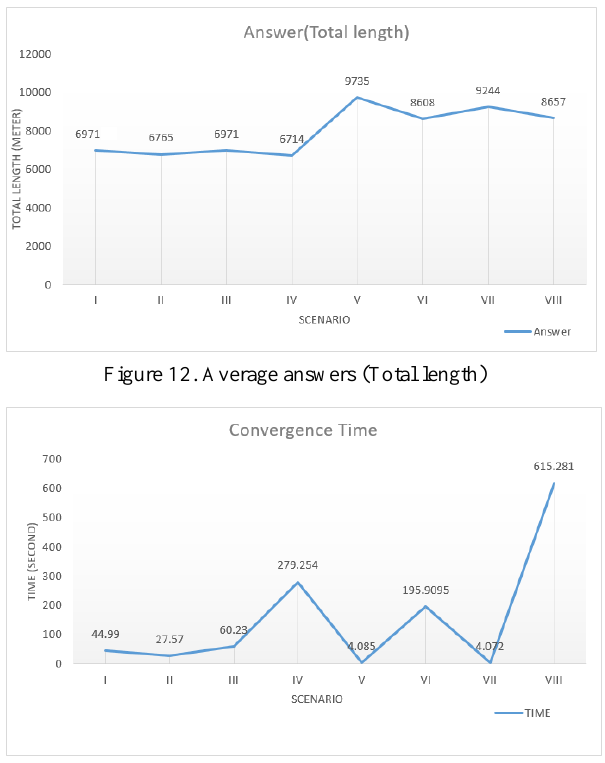
Figure 13. Average